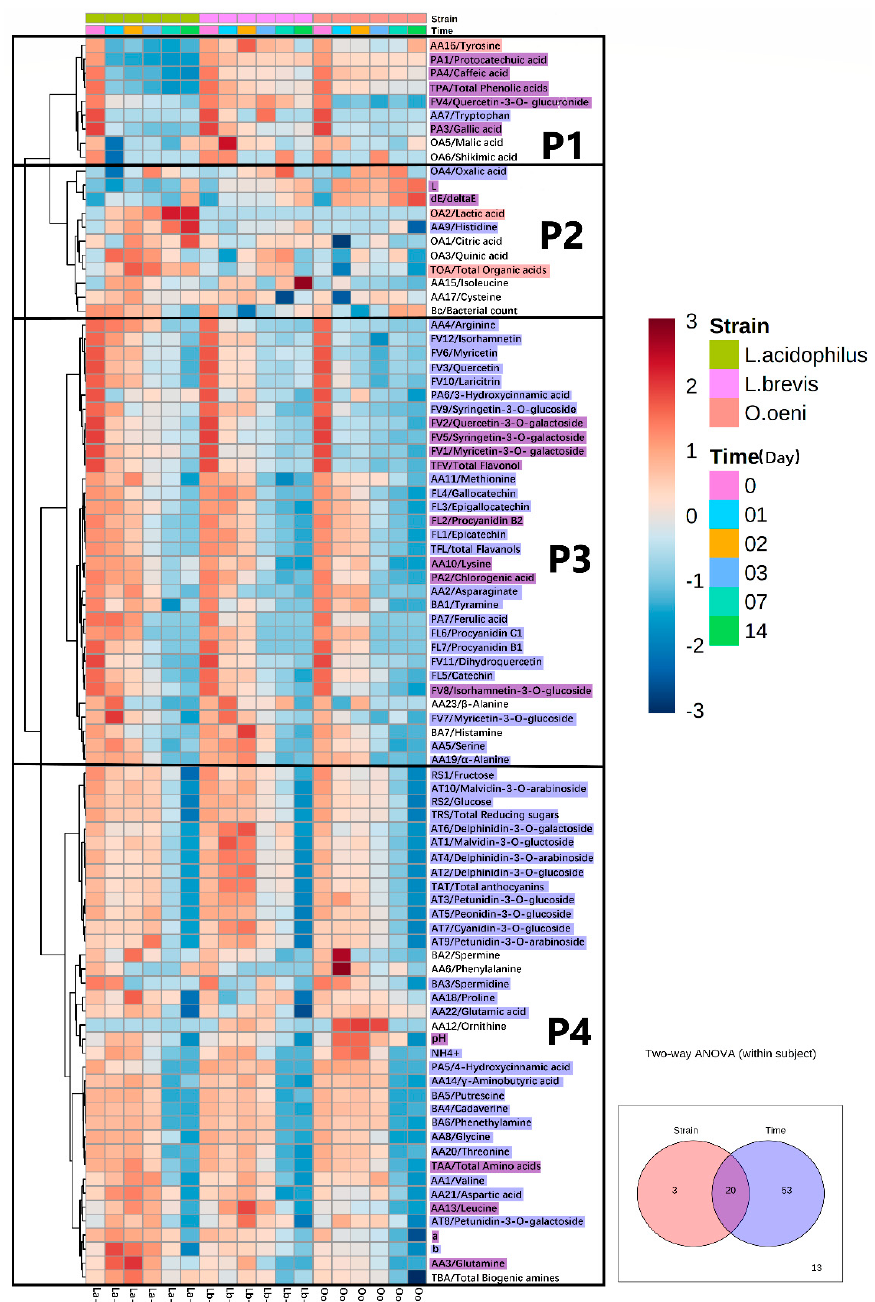
Figure 2. Evolution of all the compounds in the inoculated bog bilberry juices 0–14 days and a two-way ANOVA analysis for both strain and time effects and their interactions. The compound names colored with “ ” and “ ” shows the variables mainly affected by strain or time, respectively; the compounds colored with “ ” show the variables affected by both strain difference and time ( p < 0.05). Compounds without color are not affected by the main effects.